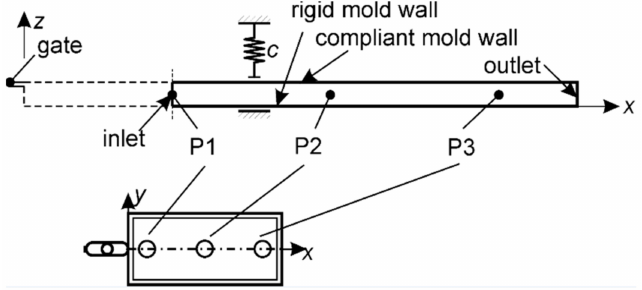
Figure 6. Computational domain.